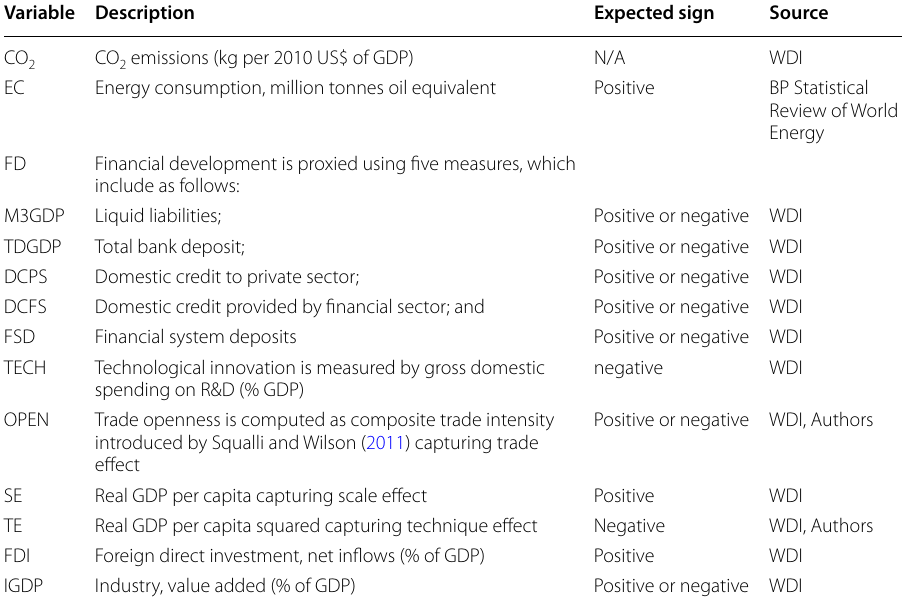
Table 2 Definition of variables and data sources